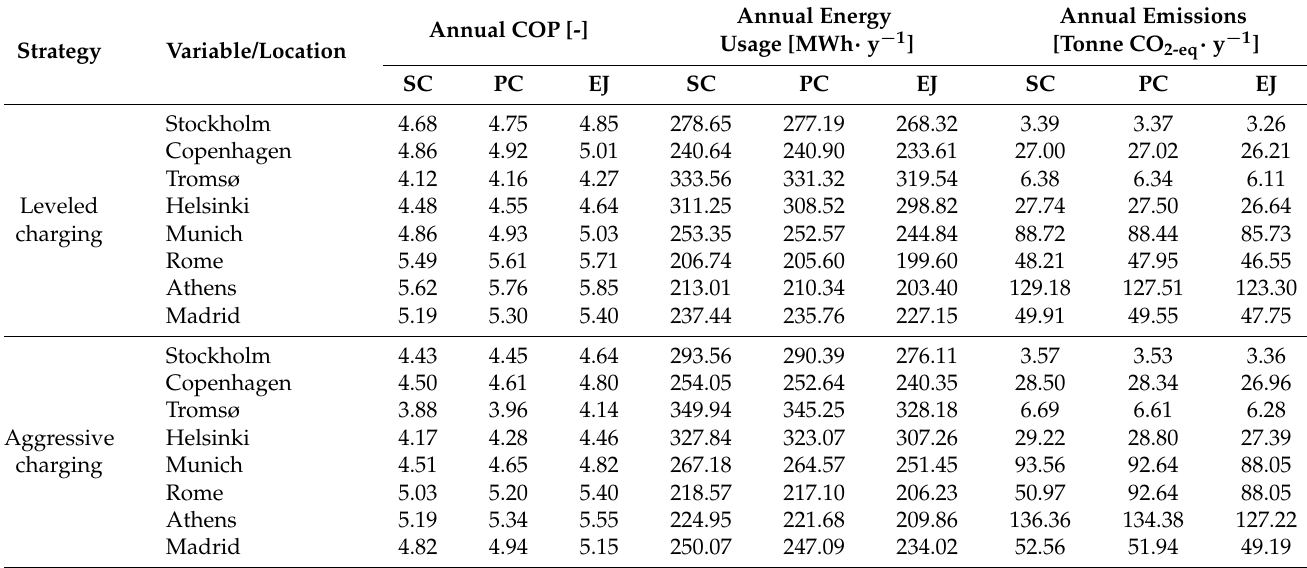
Table 5. Annual COP, energy usage, and emissions (TEWI) of the investigated systems at the selected locations when applying the leveled charging